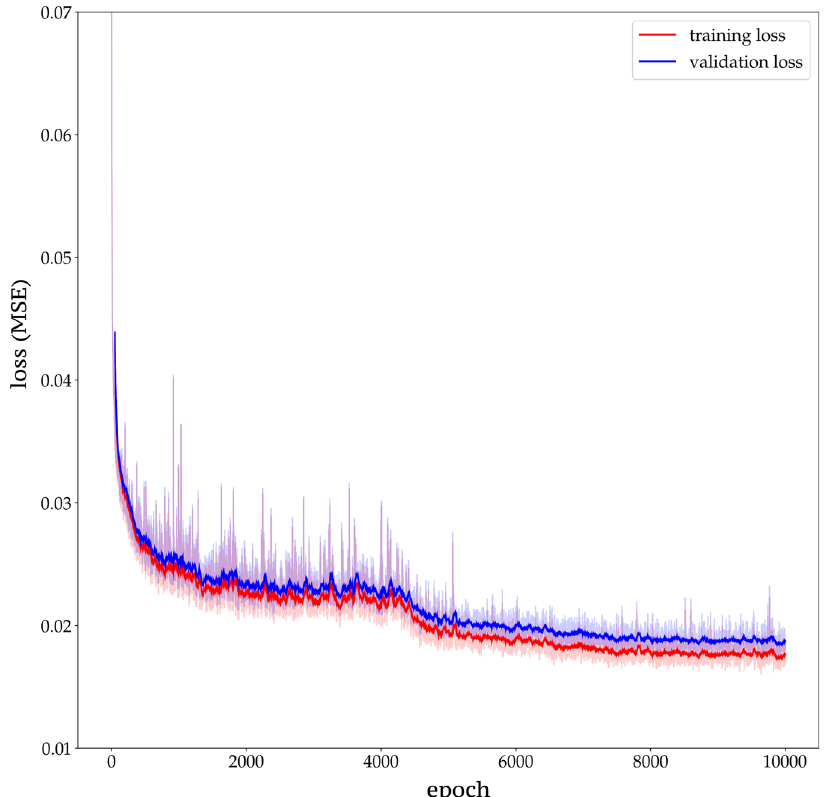
Fig. 3 DNN ’ s learning curve. Learning and validation loss curve for the training procedure. Metric losses are in Mean Squared Error values. Solid curve corresponds to the averaged loss, while the soft color curve corresponds to the loss per